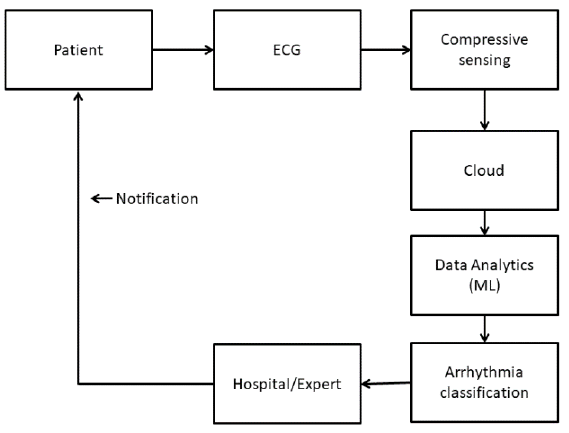
Figure 1. A generalized block diagram of an IoT-based healthcare system.